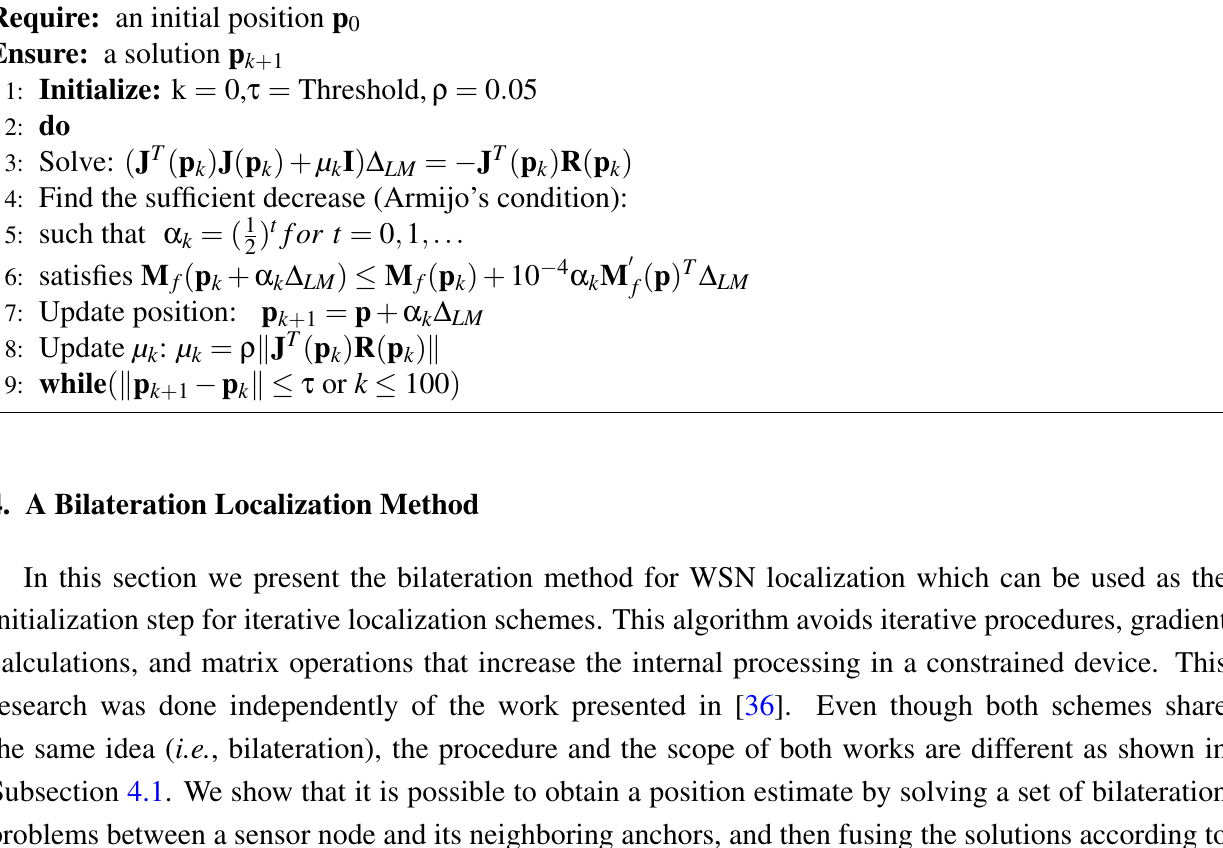
Algorithm 1 Levenberg–Marquardt